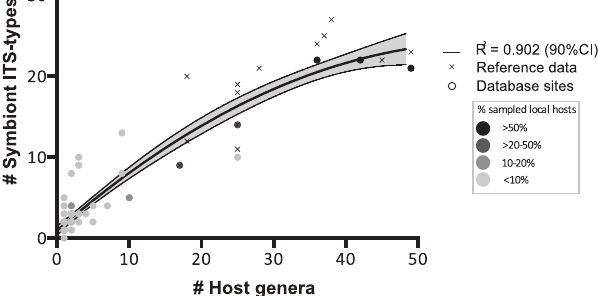
Figure 3. Accumulation curve of Symbiodinium ITS-types versus host genera. Database sites (circles) and reference data (crosses) are included. The shaded area indicates the 90% confidence interval and the circles increasing grey intensity indicates percentage of local hosts sampled.